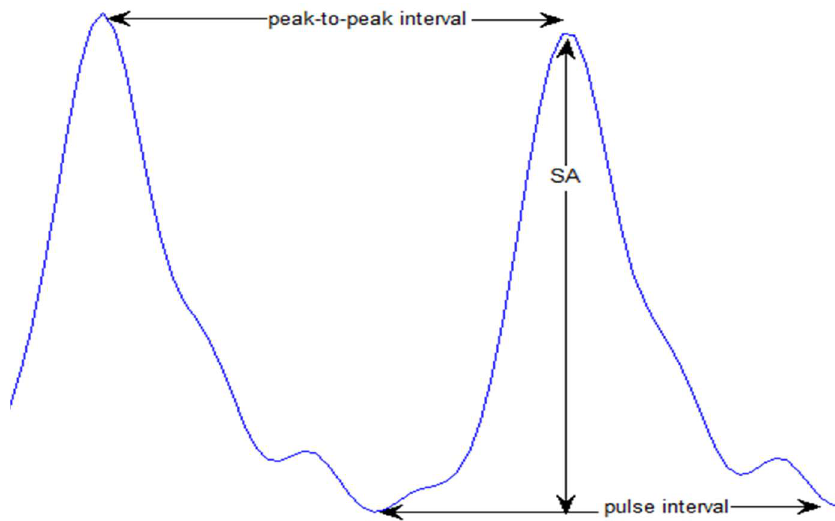
Figure 2. A display of SA along with peak-to- peak and pulse intervals.